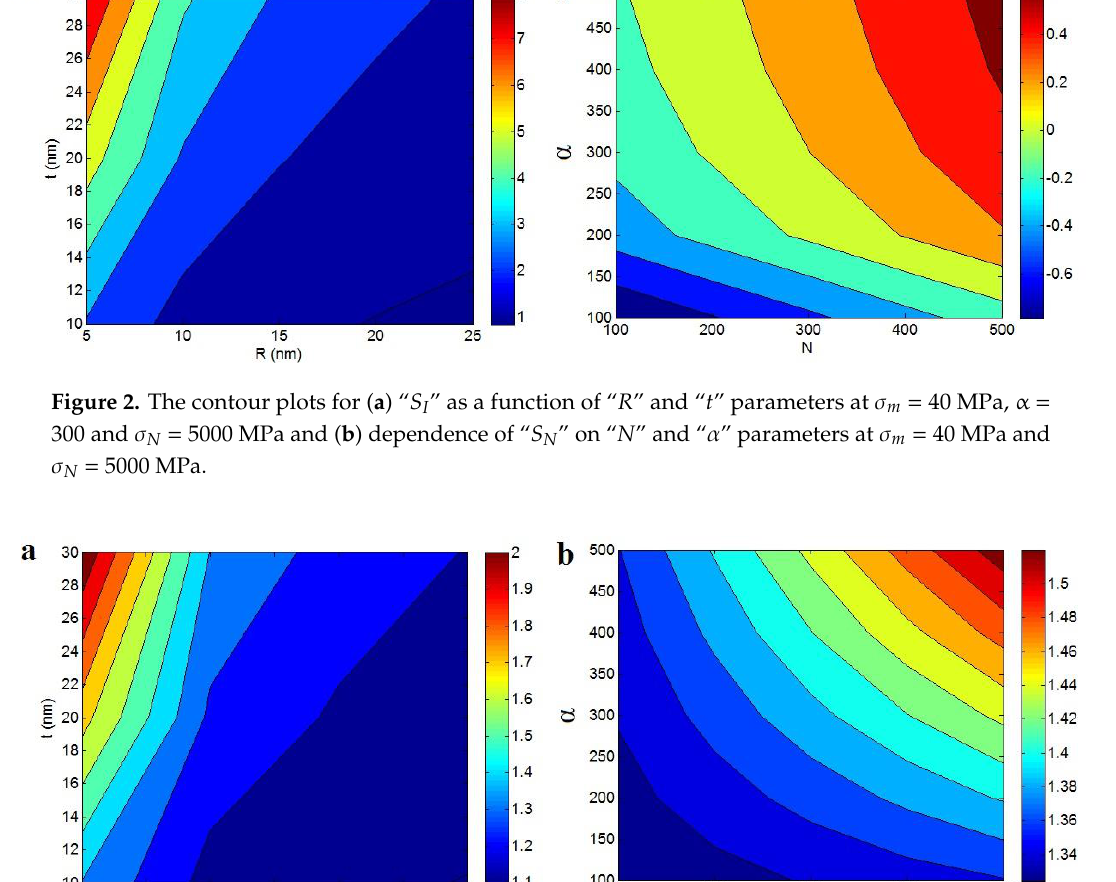
Figure 2. The contour plots for ( a ) “ S I ” as a function of “ R ” and “ t ” parameters at σ m = 40 MPa, α = 300 and σ N = 5000 MPa and ( b ) dependence of “ S N ” on “ N ” and “ α ” parameters at σ m = 40 MPa and σ N = 5000 MPa.